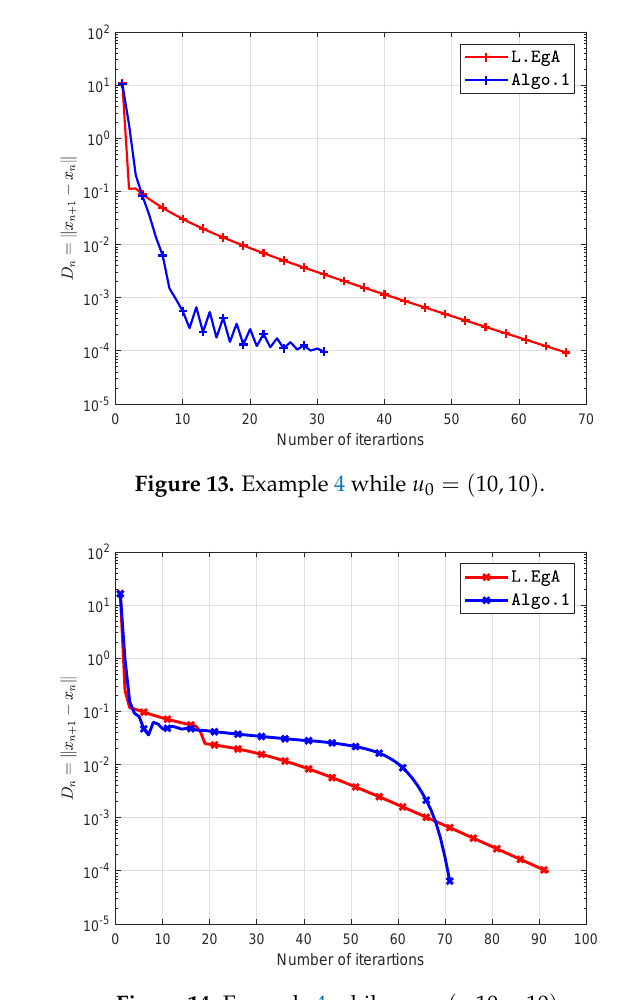
Figure 14. Example 4 while u 0 = ( − 10, − 10 )